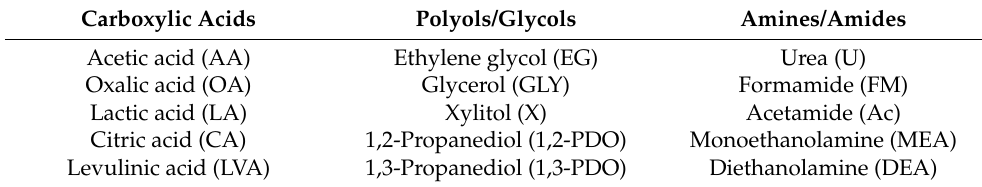
Table 2. Several hydrogen bond donors combined with choline chloride to make